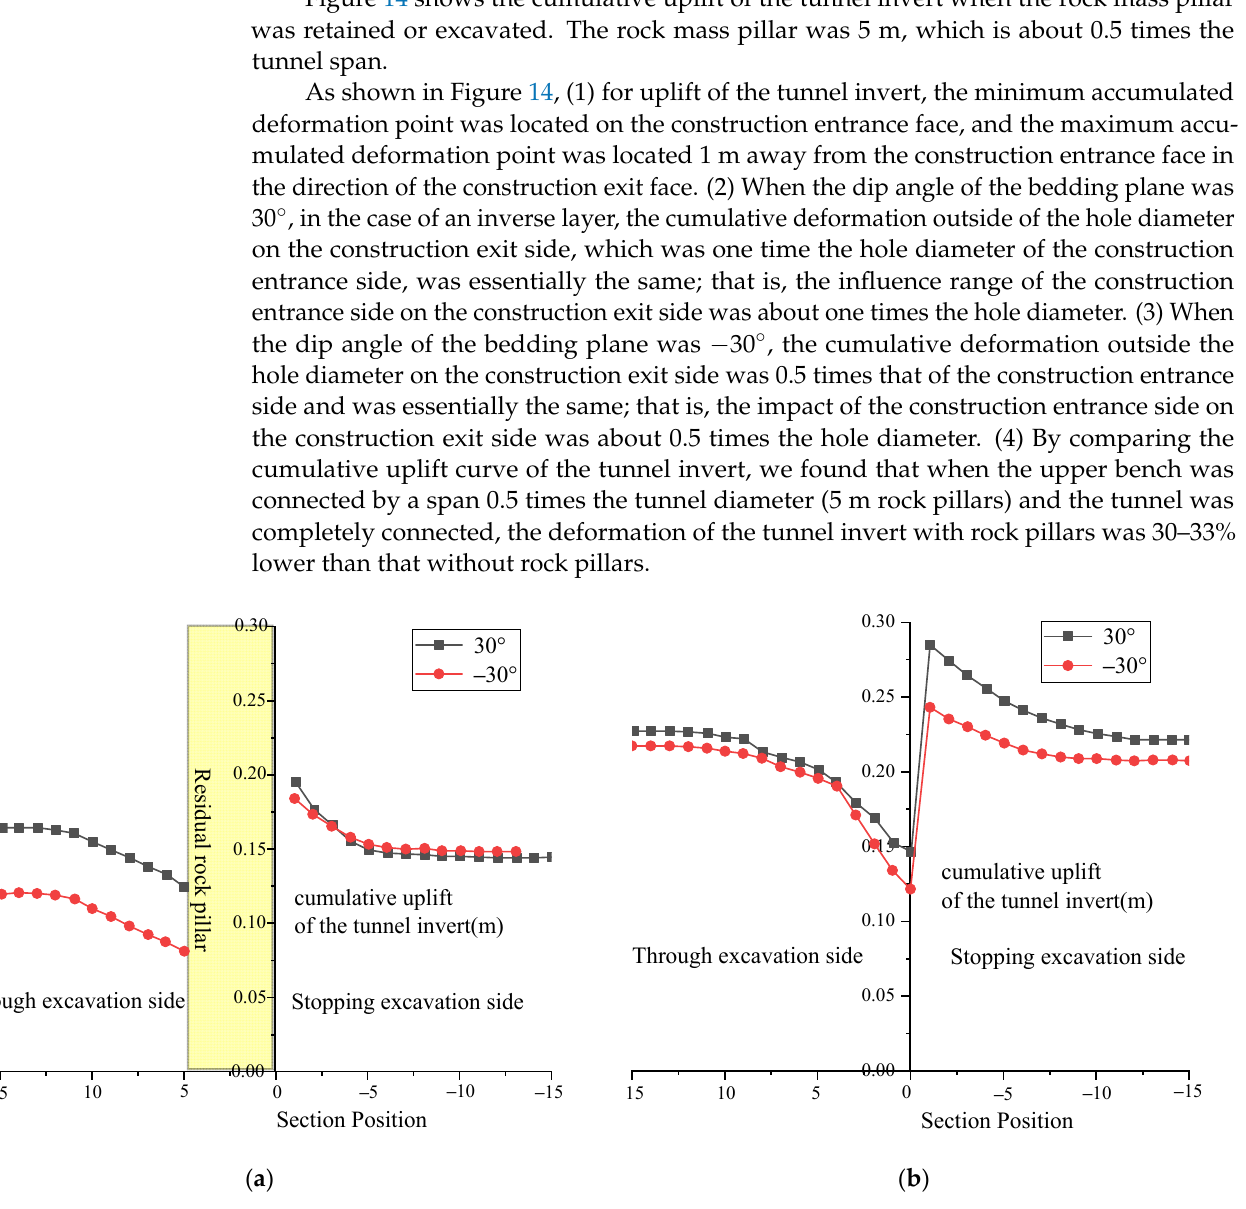
Figure 14. y = 50 m, cumulative uplift of the bottom of the tunnel. ( a ) Retained rock mass pillar and ( b ) excavated rock mass pillar.